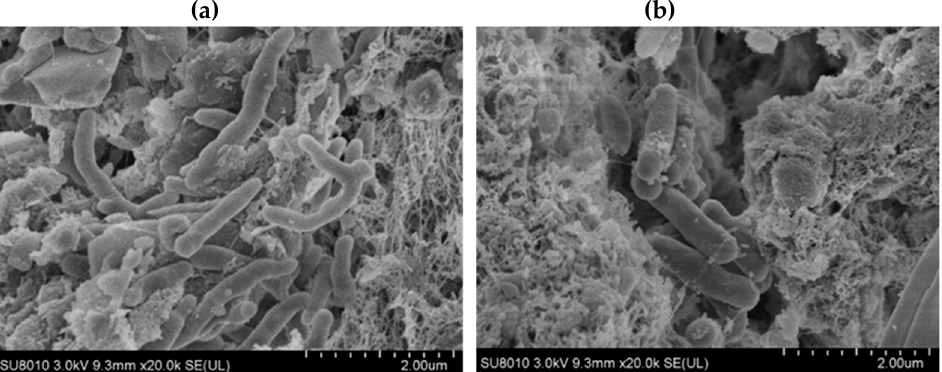
Figure 6. SEM images of an outer surface of the carrier and b interior of the sponge carrier. ( a ) the micro-organisms outside the carrier; ( b ) the micro-organisms inside the carrier.